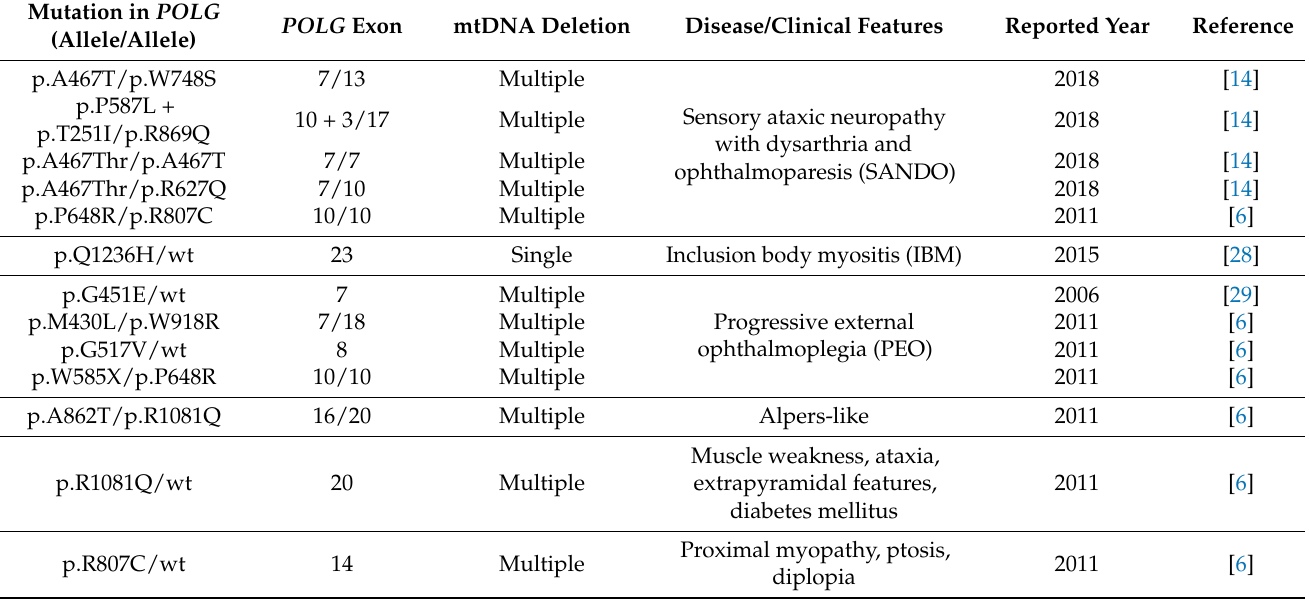
Table 2. mtDNA deletions associated with POLG mutations for various